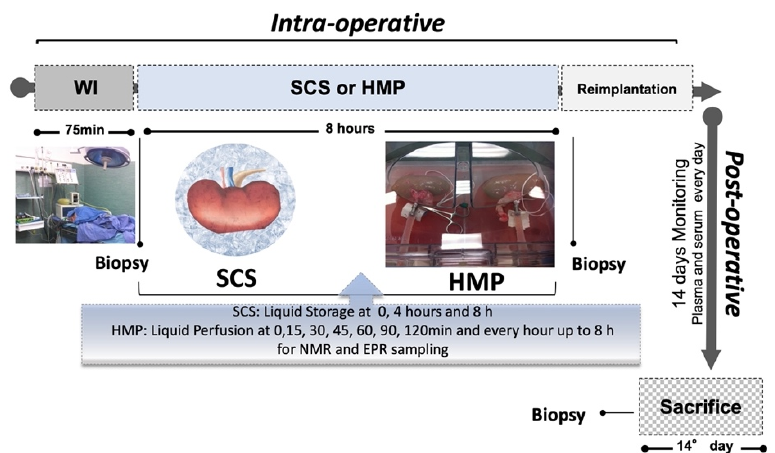
Figure 8. Sketch of the experimental protocol adopted to measure ROS production rate by EPR, metabolite concentration changes by 1 H-NMR, and oxidative damage during the intra-operative (organ preservation) and post-surgery sessions. The storage solution was sampled at 0 (T1), 4, and 8 h (T2) in SCS and at 0, 15, 30, 45, 60, 90, 120 min, and every hour up to 8 h in HMP. Blood samples were collected every day until the 7th day after re-implantation and at the sacrifice (14th day: Tend). Kidney tissues were biopted after each of the following: anesthesia (T0), 75 min of WI (T1), after 8 h of preservation (T2), and at the 14th day (Tend: sacrifice). WI: warm ischemia; SCS: static cold storage; and HMP: hypothermic machine perfusion.